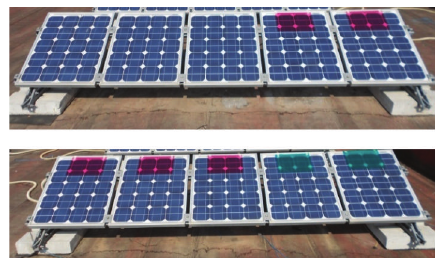
Figure 9: Ten-panel PV string. The desired shading profile is obtained superposing different kind of optical plastic film on selected PV panels.